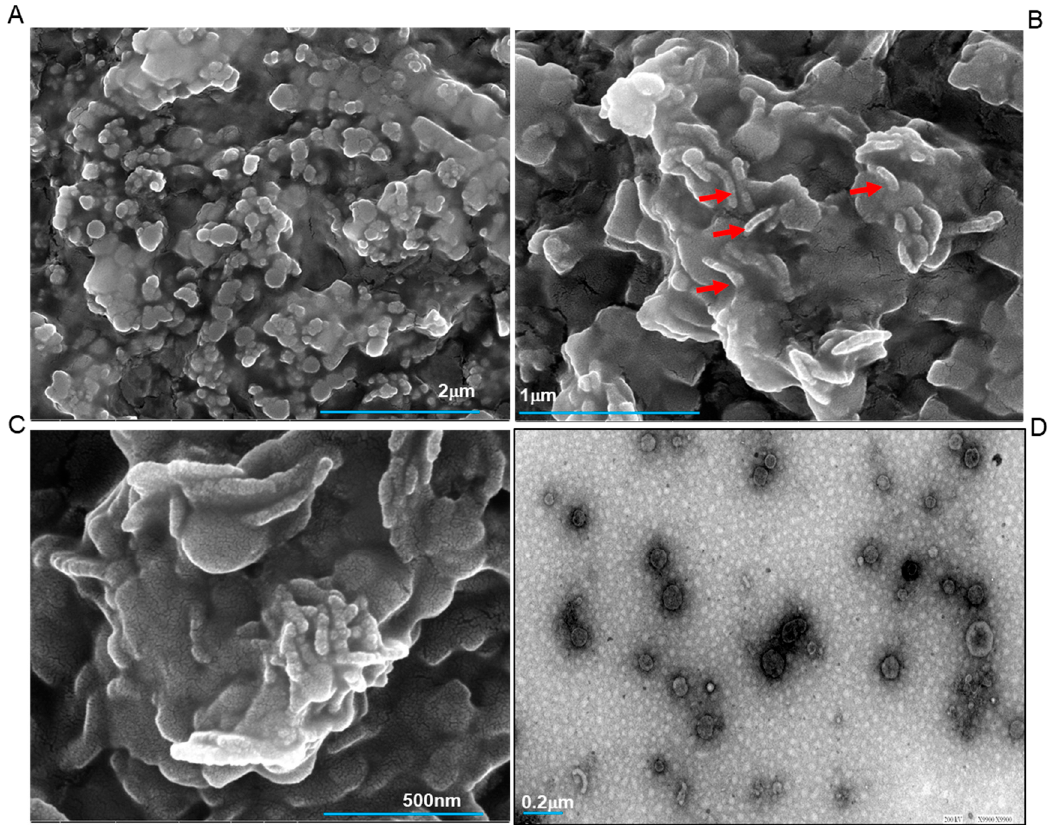
Figure 1. FESEM micrograph of calcium phosphate mineral products in the presence of normal tooth protein extract ( A – C ). The red arrows shown in ( B ) corresponds to an elongated structure of calcium phosphate. The HRTEM image of the biomineralization process is shown in ( D ). All scale bars with size are indicated at the lower part of images.